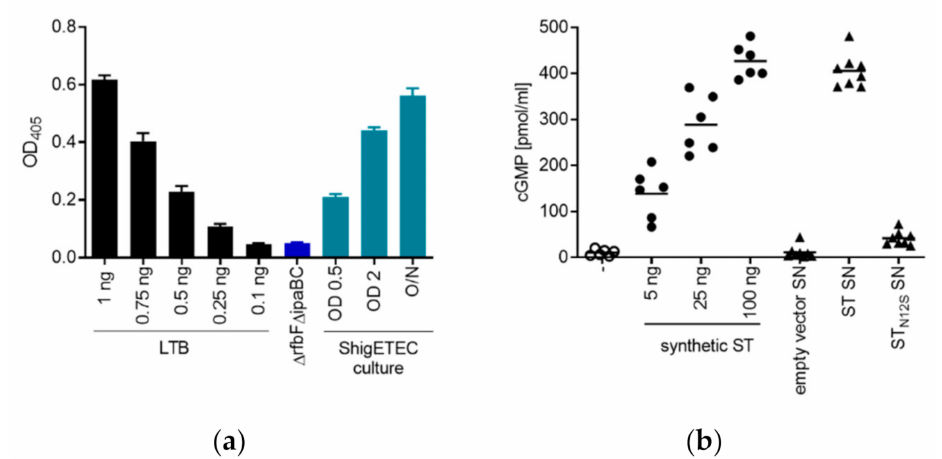
Figure 3. Expression of detoxified ETEC antigens by ShigETEC. ( a ) ShigETEC whole cell lysates were tested for the expression of LTB-ST N12S by binding to the LTB receptor, GM1 in ELISA. Bound LTB was detected by anti-CTB antibody. Expression level of LTB-ST N12S was compared to serially diluted LTB (black bars). A rough, non-invasive Shigella mutant ( ∆ rfbF ∆ ipaBC ) lacking the LTB-ST N12S fusion construct was used as negative control (blue bar). ( b ) Wild-type ST and its N12S mutant were generated recombinantly in E. coli . Supernatants (SN) of the cultures were used to stimulate T84 human epithelial cells and ST-induced cGMP production was measured by ELISA. Indicated amounts of synthetic ST were used as positive control. SN from bacteria carrying empty vector served as negative control. Triplicate measurements from two independent experiments were